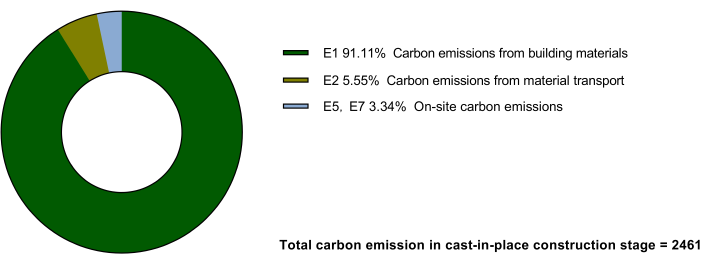
Figure 6. B1 building prefabrication method materialization stage carbon emissions.